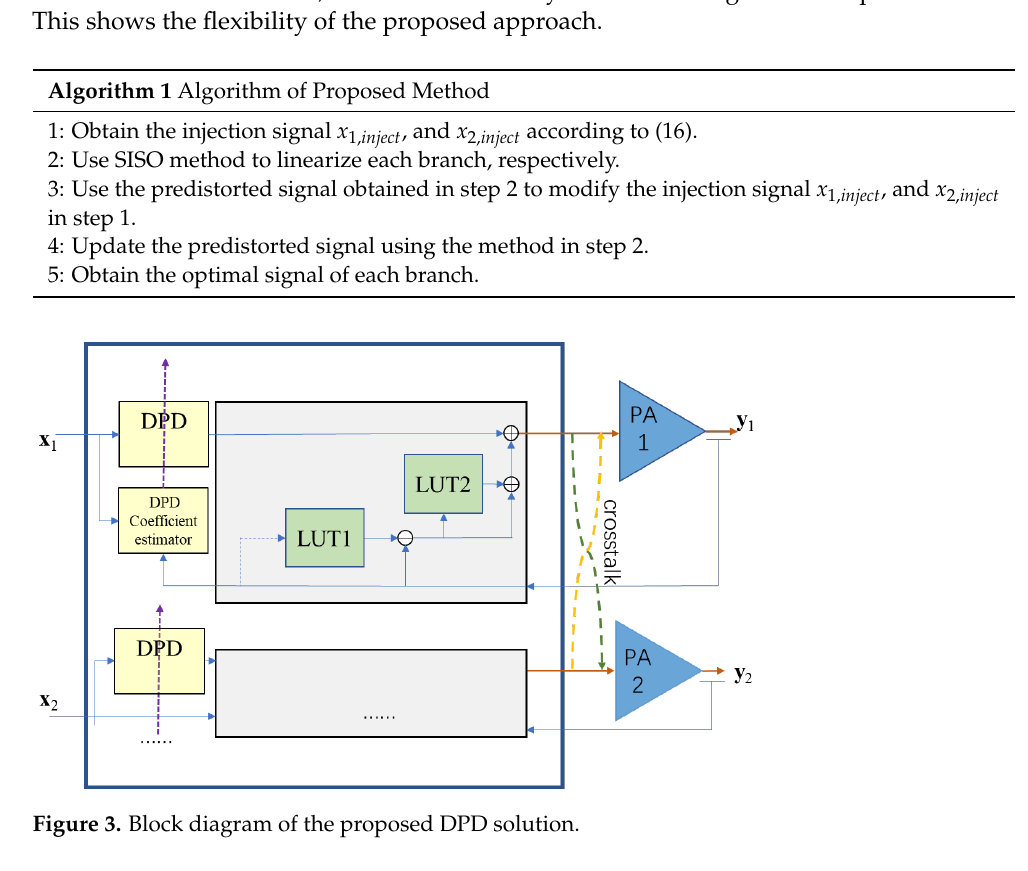
m-CPWL model Figure 4. Normalized frequency power spectrum density (PSD) of p roposed DPD models (simulation).